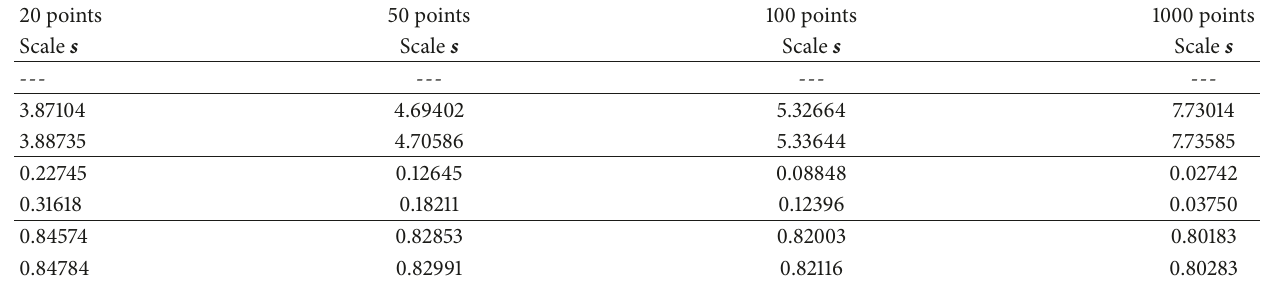
Table 59: G-h distributions with 30% noise level.